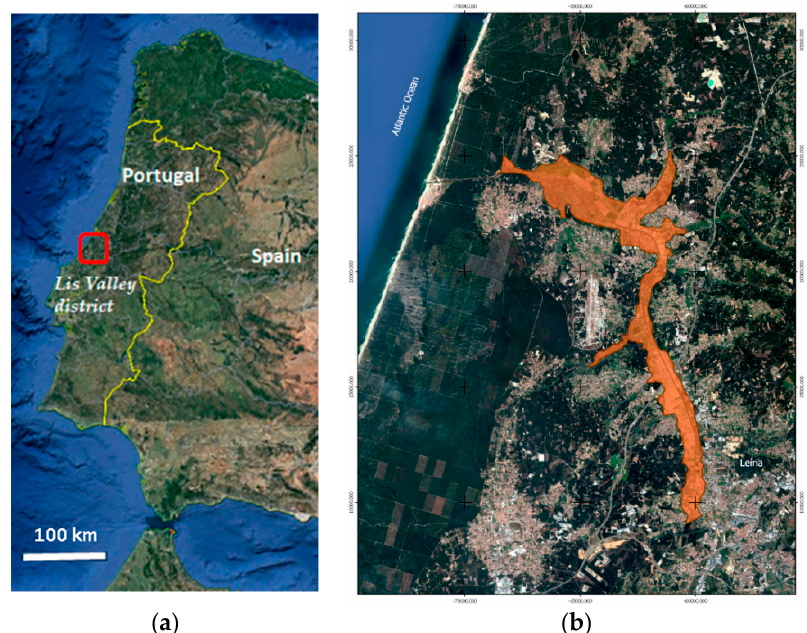
Figure 1. Location of the Lis Valley Irrigation District in Portugal ( a ), and in the center region ( b ). (source: Google Maps, https://maps.google.pt).